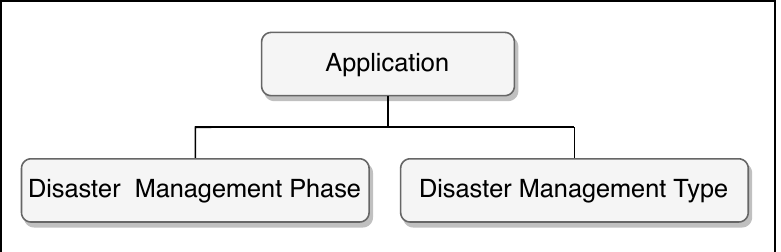
Figure 7. Dimensions of social media applications in disaster